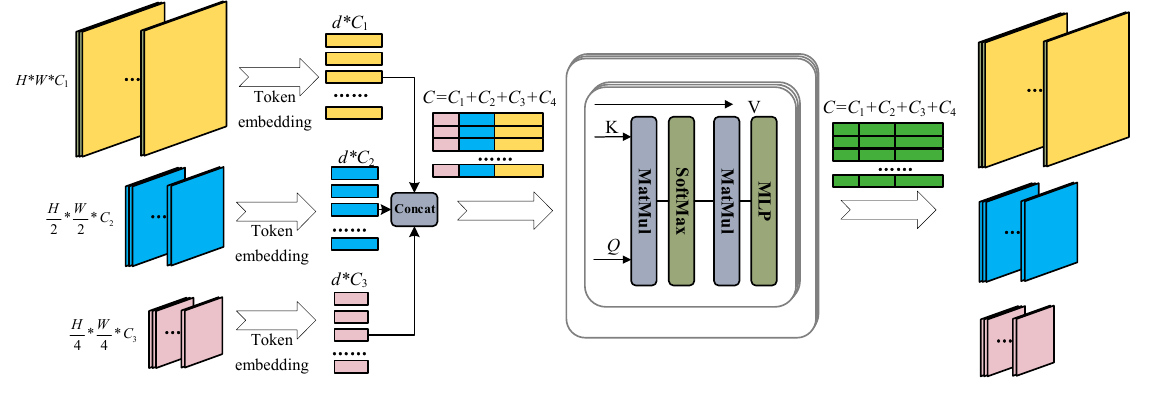
Figure 6. Channel-Wise Self-A tt ention module.